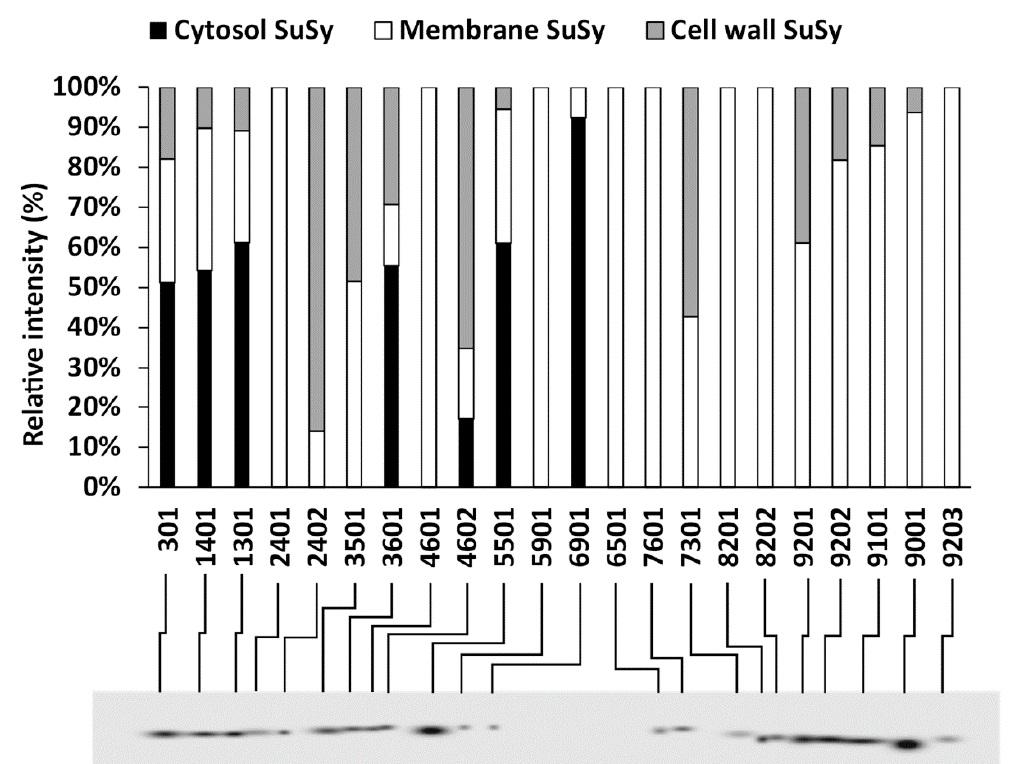
Figure 8. Alignment of SuSy spots obtained from the analysis of the two-dimensional electrophoresis of proteins of cytosol (black bars), membranes (white bars) and the cell wall (grey bars) of nettle stem samples. The intensity of spots is defined as the percentage of relative intensity. Spot numbering was done automatically using PDQuest software. Below, the virtual blot (master blot) summarizes all of the SuSy spots identified in the three samples.